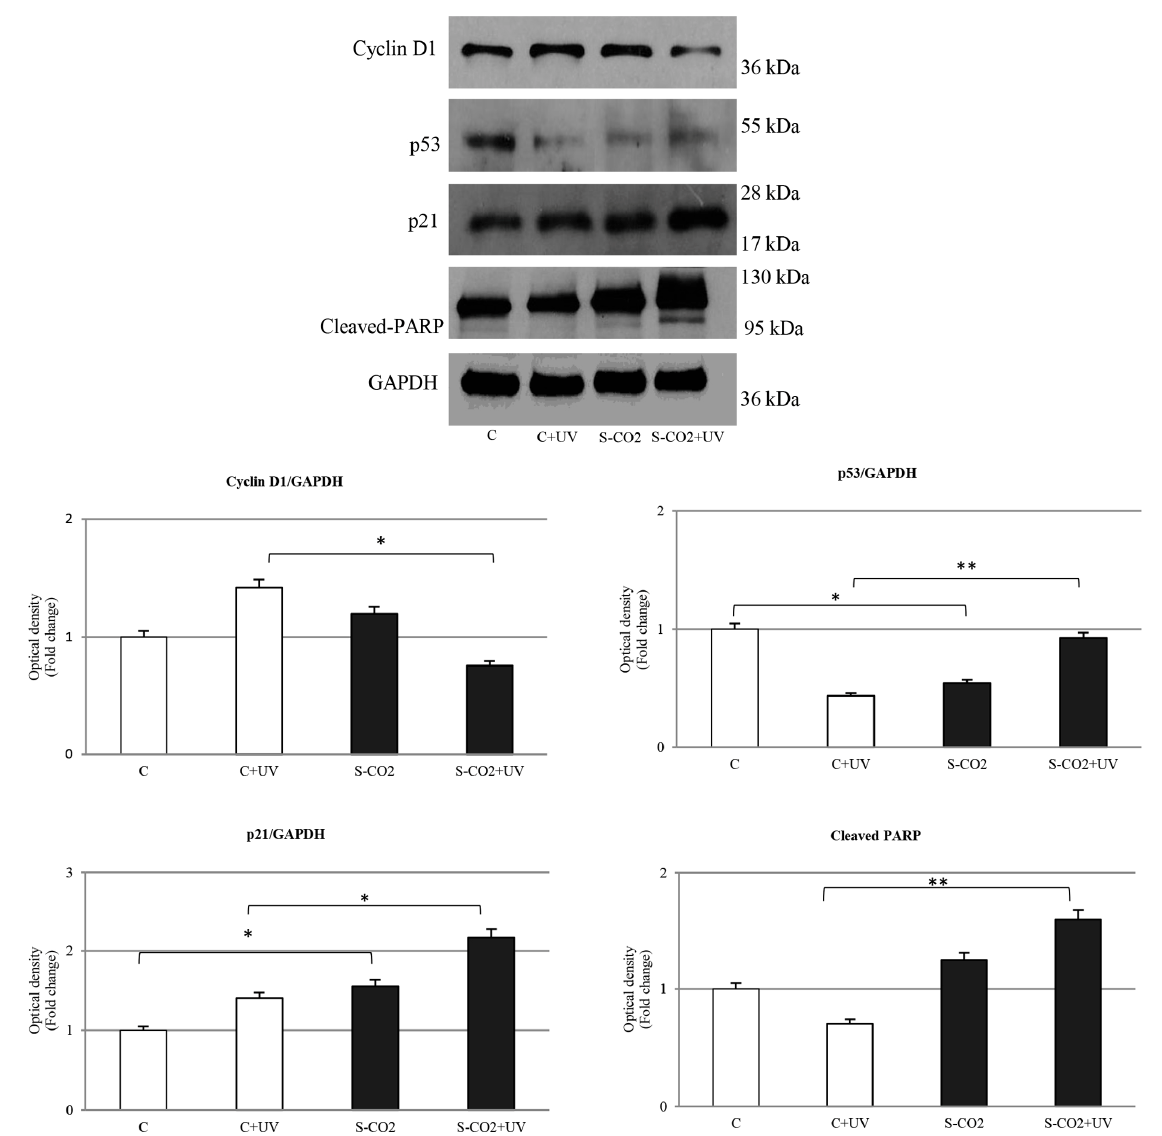
Figure 8. Western blot analysis of Cyclin D1, p53, p21, and PARP (poly ADP-ribose polymerase) protein levels in C32 cells treated or not with S-CO 2 extract for 24 h, both in the presence and absence of UV. The histograms represent the mean ± SD of three separate experiments in which band intensities were evaluated as optical density (OD) and expressed as fold change relative to control; * p ≤ 0.05; ** p ≤ 0.005 vs. control (C) and control + UV (C+UV).